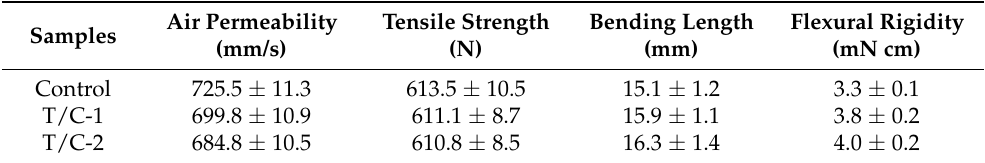
Table 2. Air permeability, tensile strength, bending length, and flexural rigidity of the coated T/C blend